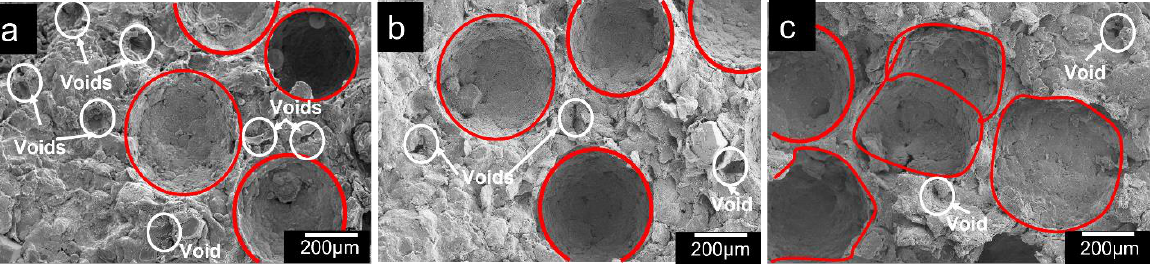
Figure 7. SEM micrography of porous Al composites at sintering temperature of 590 °C and at varying sintering time ( a ) 350 MPa, 120 min, ( b ) 380 MPa, 90 min, and ( c ) 400 MPa, 60 min (Red circles represent pore shapes and the voids are encircled by white circles).